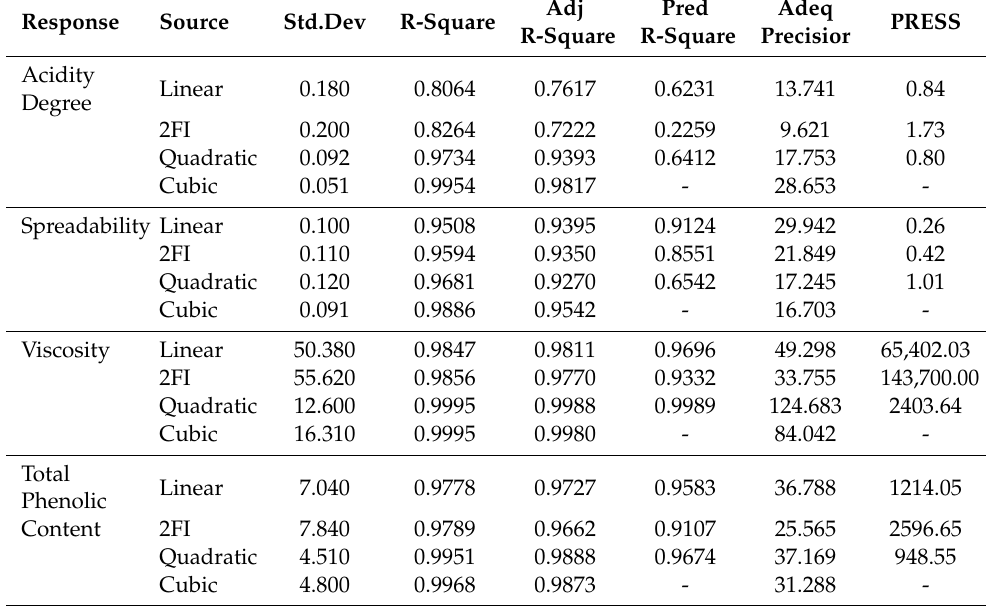
Table 3. Characterization for the statistical design model of arabica co ff ee ground nanoparticles gel